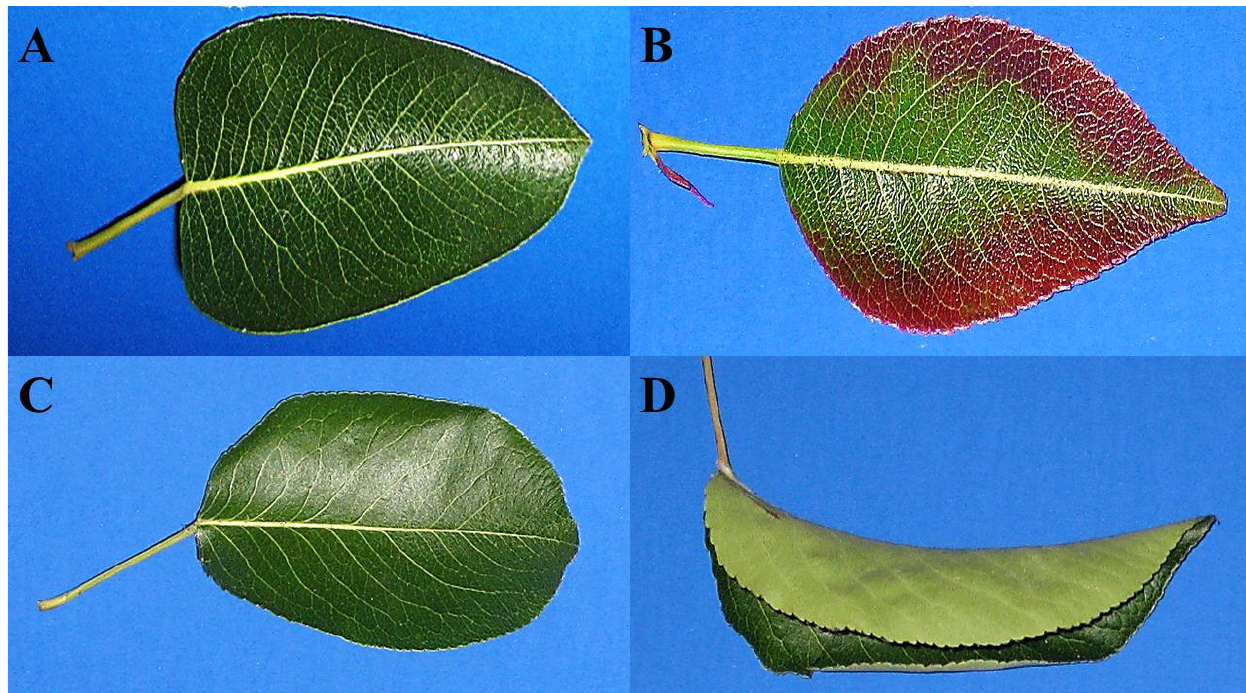
Figure 1. Leaves of Pyrus communis selections 8824-1 and 9328-1 without and with PD phytoplasma foliar symptoms. ( A ) A non-symptomatic leaf in selection 8824-1, ( B ) a leaf with reddening symptoms in selection 8824-1, ( C ) a non-symptomatic leaf of selection 9328-1 and ( D ) a leaf with curling symptom in selection 9328-1. Images are of mature leaves from the middle part of the tree (approx. 150 cm height).